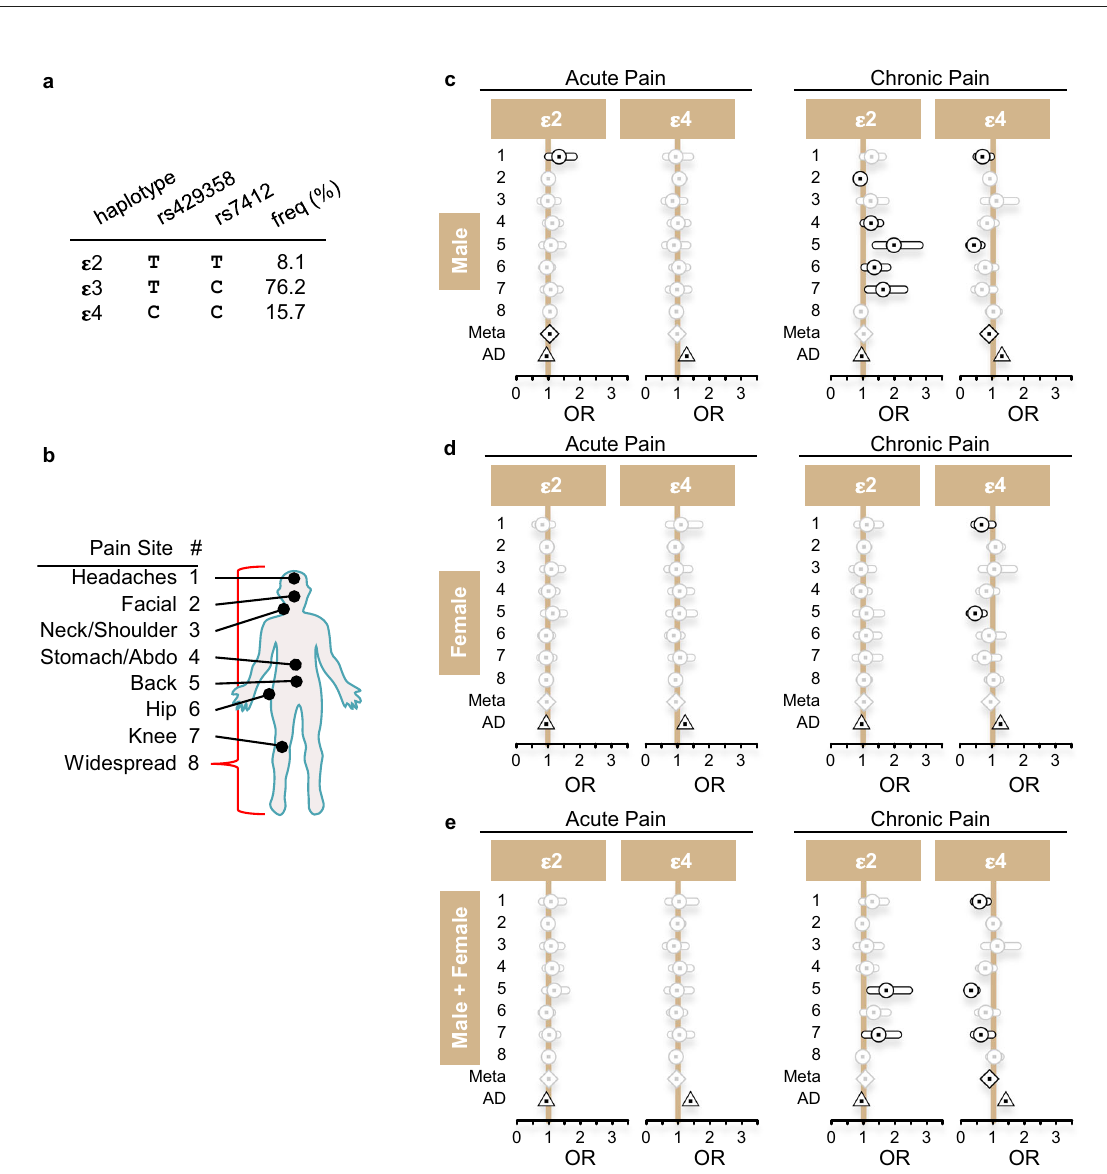
Fig. 5 Polymorphisms in APOE are associated with chronic pain in humans. a Haplotypes in the human APOE gene. The haplotypes are composed of speci fi c alleles of SNPs rs429358 and rs7412, at distinct frequencies in the UK Biobank (UKB) cohort. ε 3 is the ancestral haplotype. b A schematic diagram of human body indicating reported pain sites. c Haplotypic effects of APOE in human pain in males. For c – e , the effects are depicted on the odds ratios (OR) scale, with 95% con fi dence intervals, for each pain sites (circles), for inverse standard-error weighted meta-analyzed results (Meta, lozenges), and for Alzheimer ’ s disease (AD, triangle). From left to right; effect of ε 2 and ε 4 in acute pain, and ε 2 and ε 4 in chronic pain. Insigni fi cant P -values ( P > 0.05) grayed out. d Haplotypic effects in females only. e Haplotypic effects in males and females combined. See methods section for description of analyses and statistical approaches. See Supplementary Data 6 for details of the analyses, including statistics and number of cases/controls.